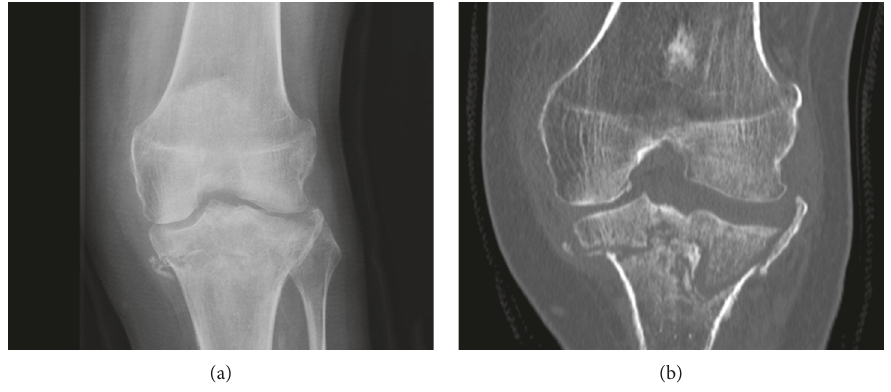
Figure 7: Delayed healing. (a) AP radiograph and (b) coronal CT scan before Exogen treatment.